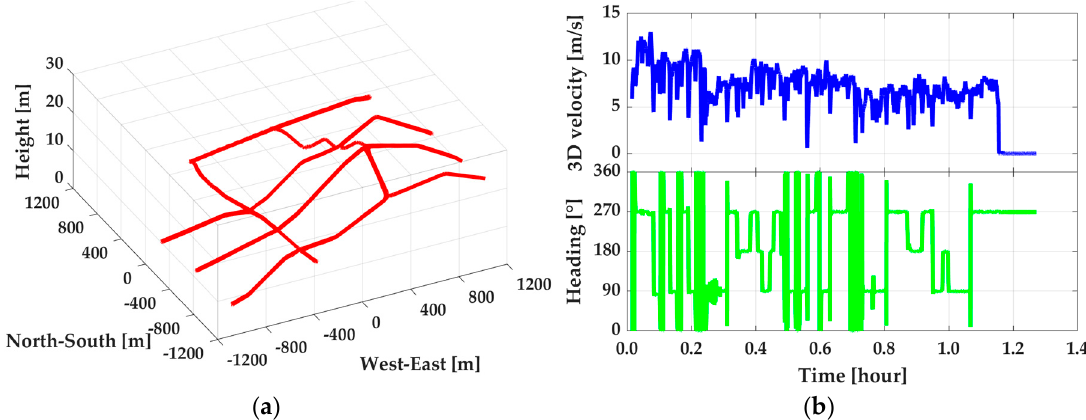
Figure 4. Trajectory in navigation frame ( a ) and the 3D velocity and movement direction ( b ) of the vehicle.